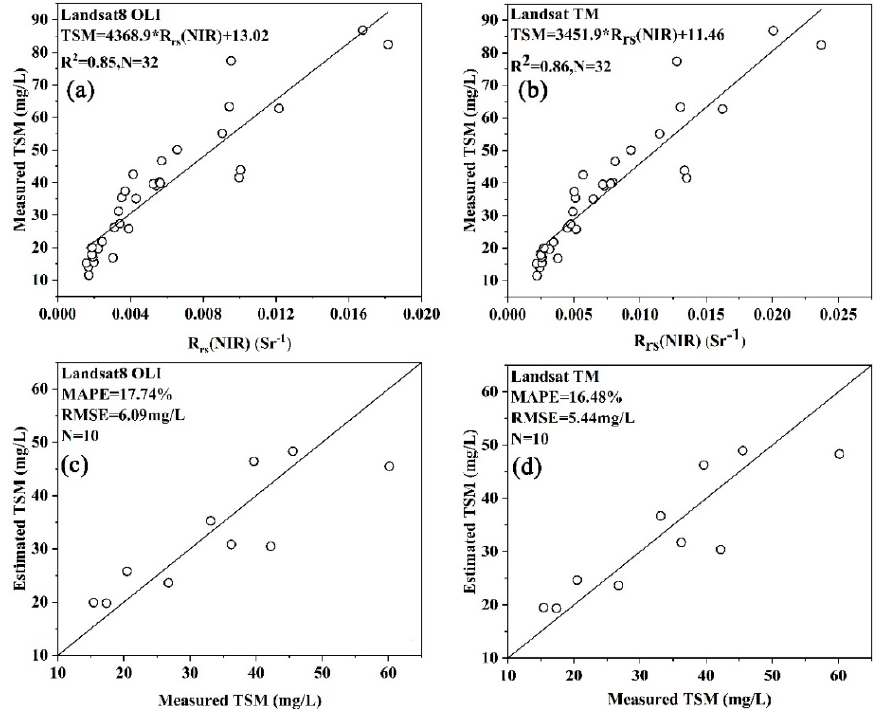
where y and x are TSM and Landsat 8 OLI R rs (NIR), respectively. Figure 4. Fitting curve of TSM and Rrs for ( a ) Landsat 8 OLI and ( b ) Landsat TM; Comparing the estimated and measured TSM based on the validation data for ( c ) Landsat 8 OLI and ( d ) Landsat TM.